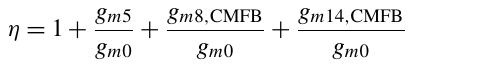
signal bandwidth. The resulting − 3 dB bandwidth of the sys- tem is 51